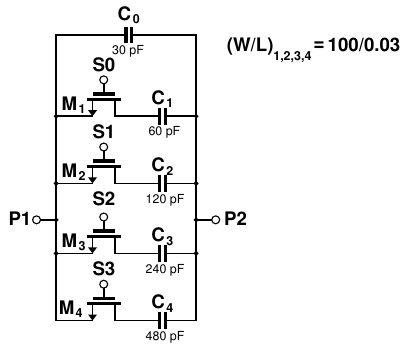
Figure 11. Circuit schematic of the variable capacitor C F . The specified width/length are reported in µm for each